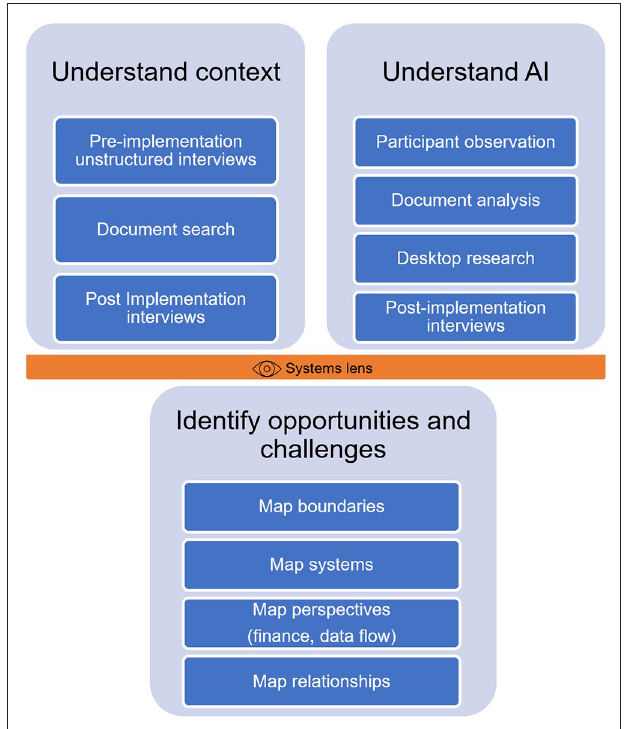
FIGURE 2 | Research approach in three